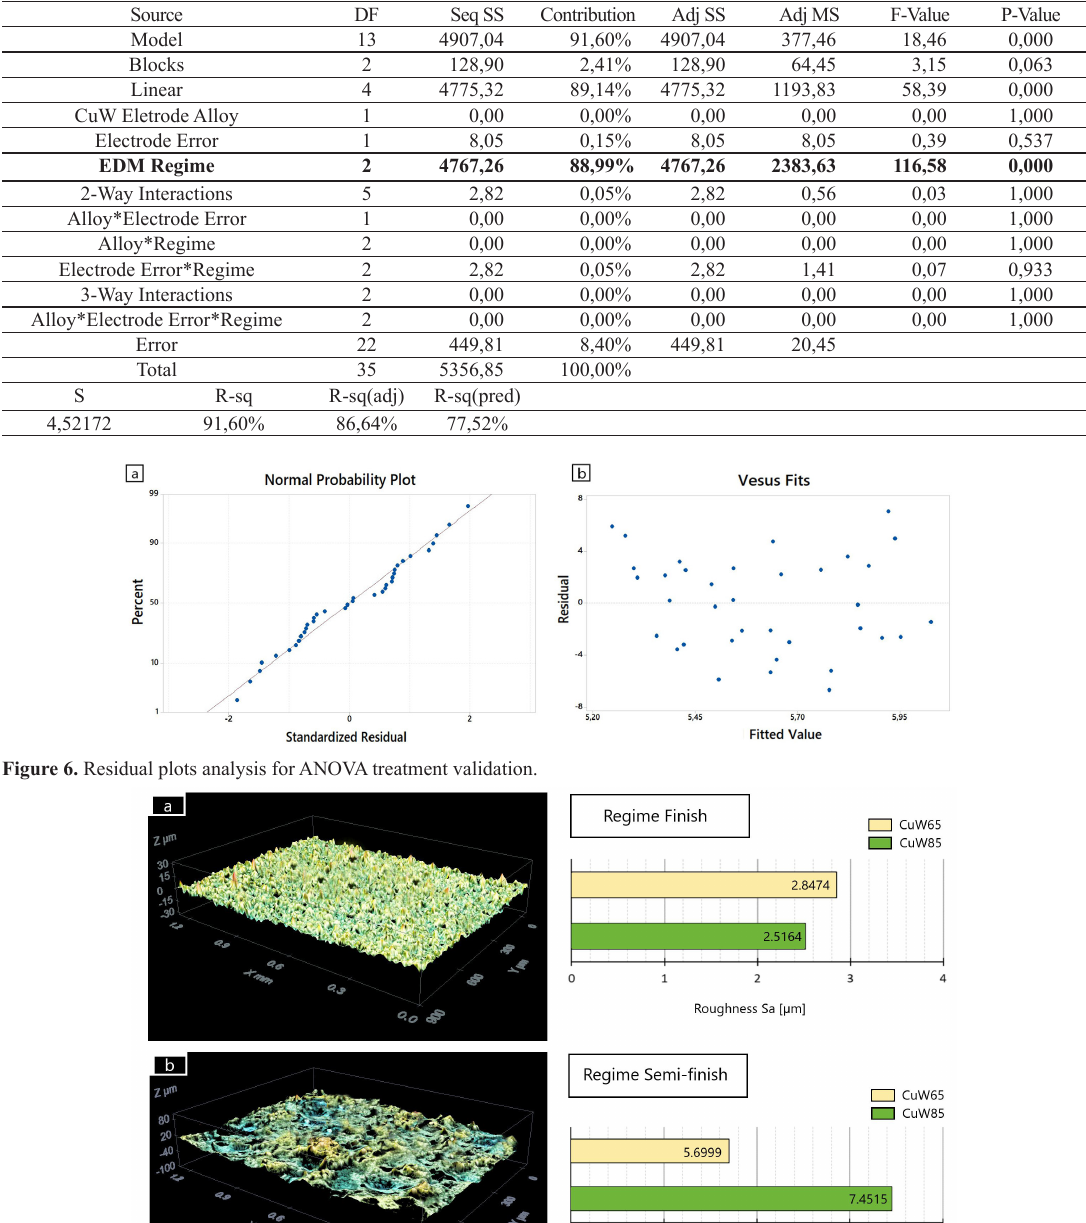
Table 4. ANOVA table for ED-Machining effects on WC-Co circularity.